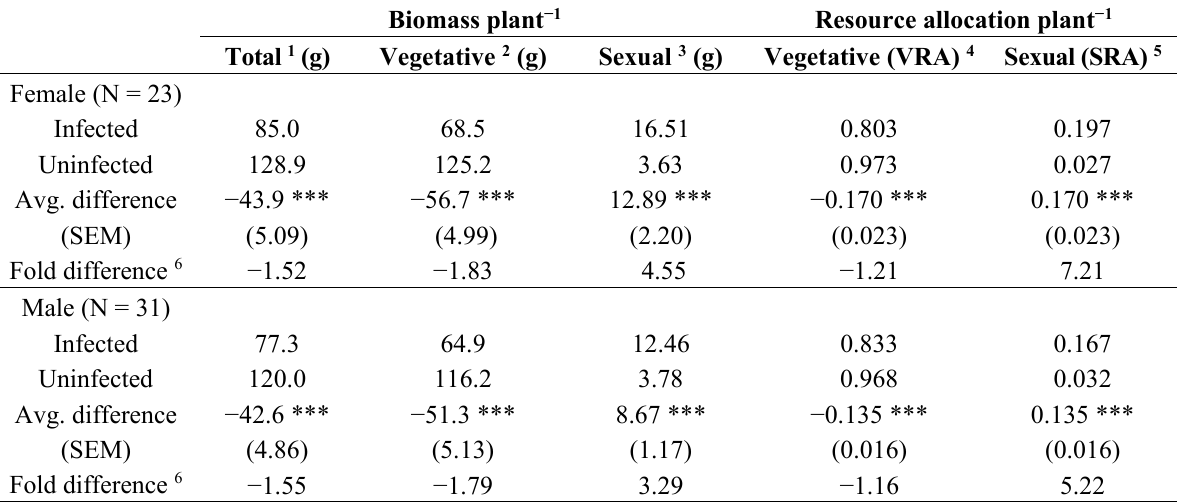
Table 1. Mean resource partitioning for female and male genotypes of buffalograss that were either infected or uninfected with the pistil smut fungus. For each genotype, two replicate clonal plants were infected with pistil smut and two remained uninfected. Means are the clonal averages across genotypes from greenhouse grown plants. Mean differences between infected and uninfected clones were tested for significance using Student’s paired t-test. Standard error of mean =